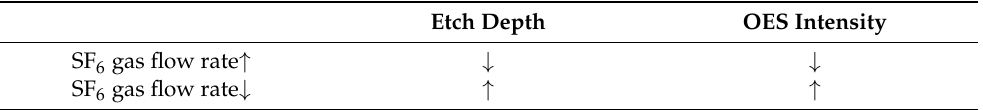
Table 6. Phenomenon by changes in SF 6 gas flow